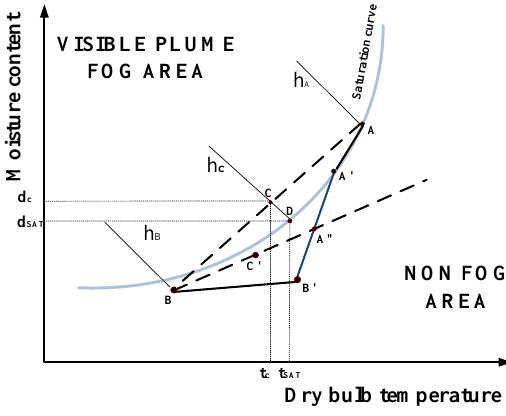
Figure 1. Psychrometric chart of saturated air.